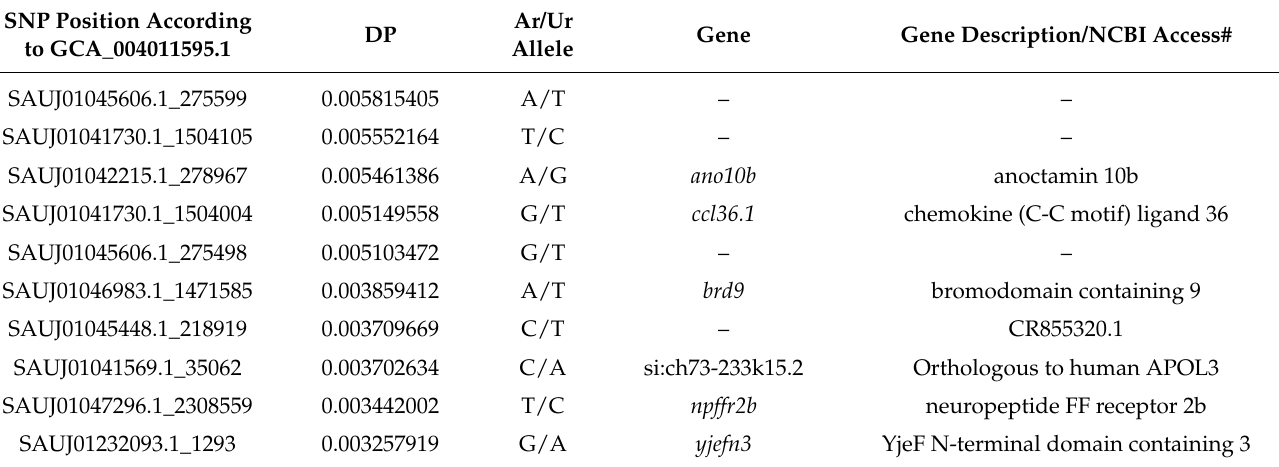
Table 2. Discriminating loci for Volga-Ural and Aral-Alakol groups with maximal discrimination power (DP). SNP Position According to